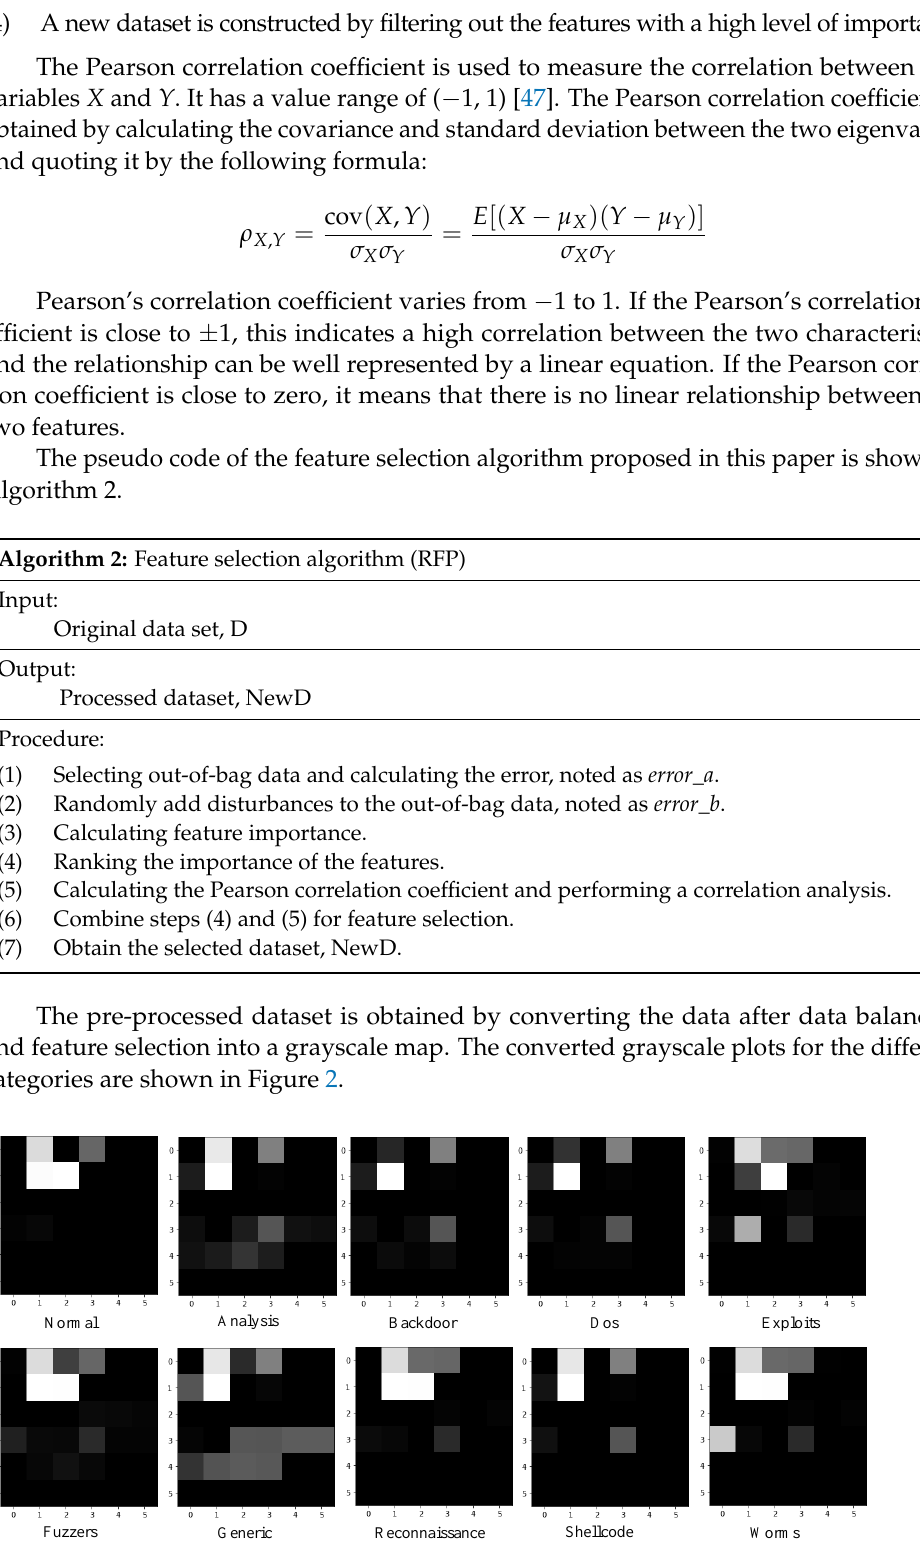
Figure 2. Converted grayscale map.